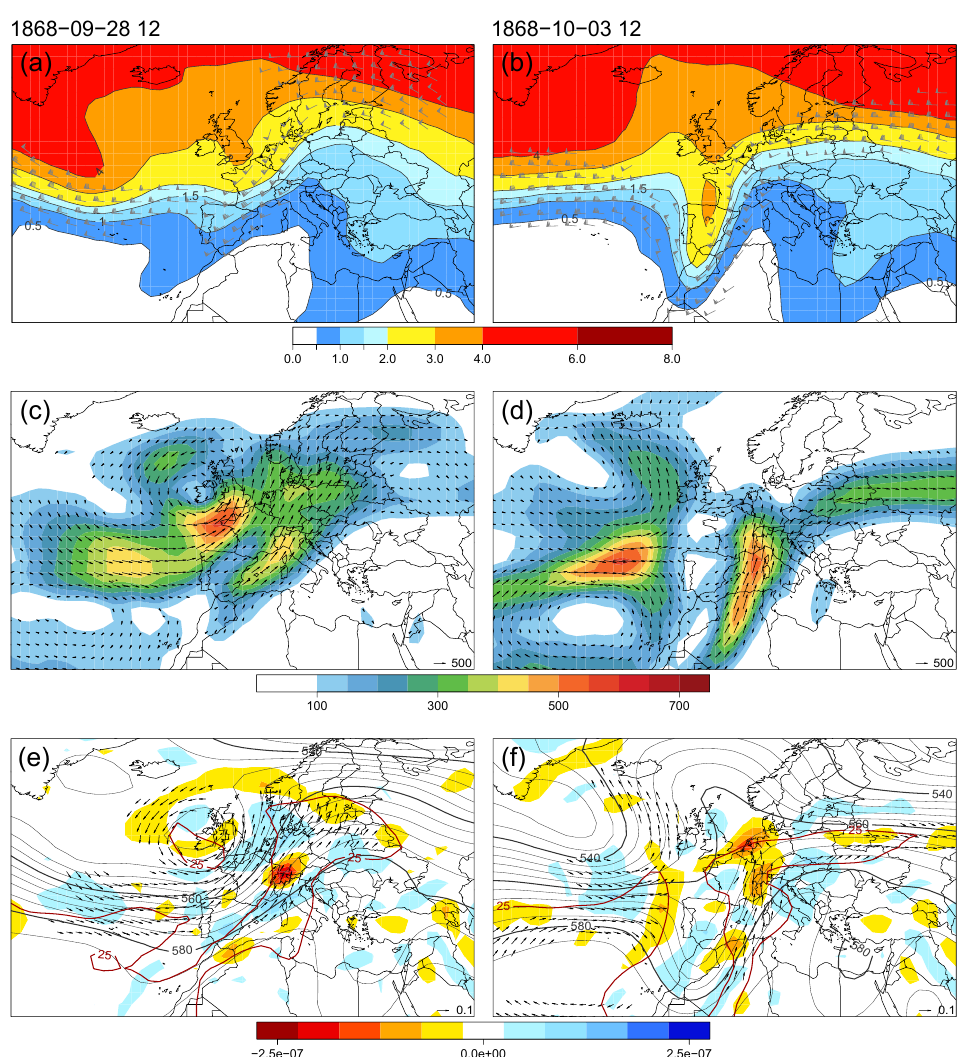
Figure 7. As in Fig. 6, but for 28 September 1868 12:00UTC (a, c, e) and 3 October 1868 12:00UTC (b, d, f) .